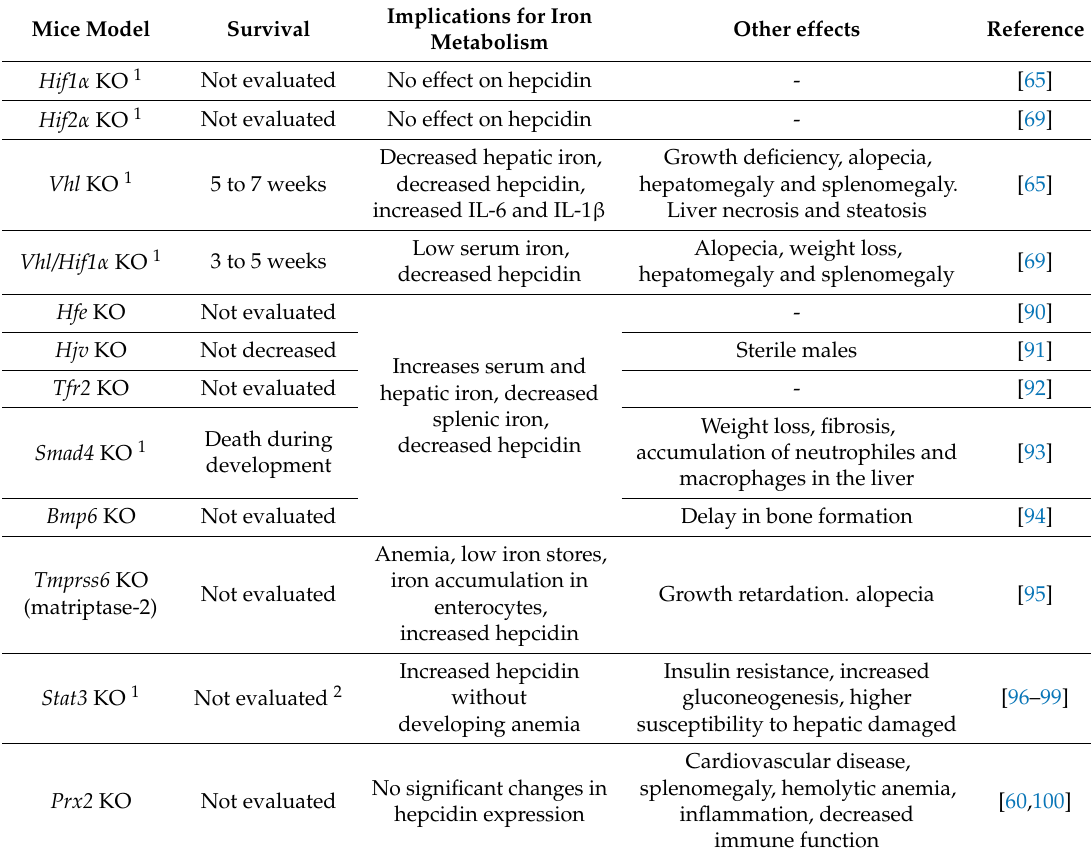
Table 2. Genetically modified mouse models for the study of hepcidin regulation by hepatic hypoxia. Implications for Iron Mice Model Survival